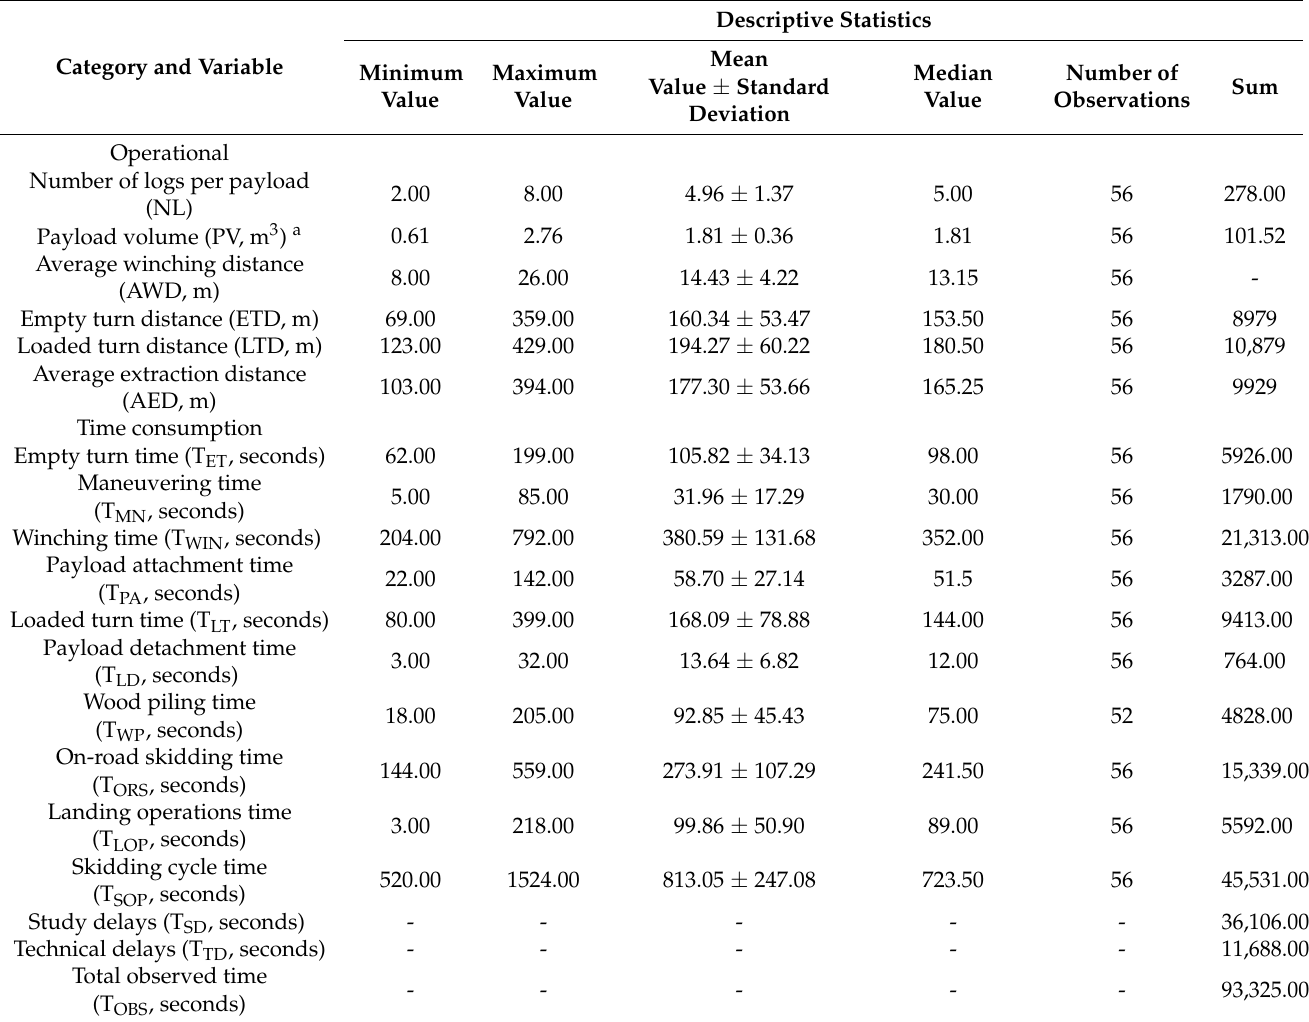
Table 6. Descriptive statistics of operational and time consumption variables for skidding